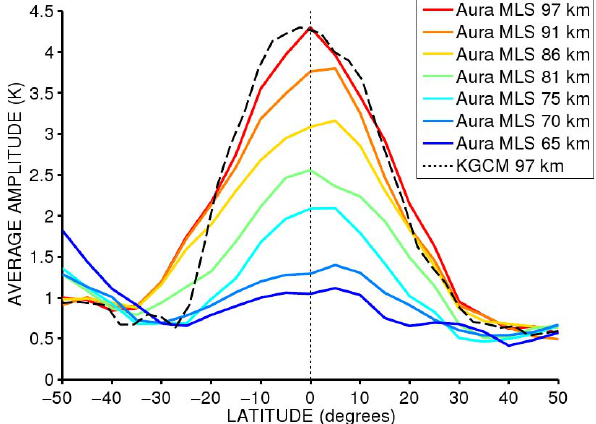
Fig. 9. Average amplitude as a function of latitude for 16 E1 waves identified in Aura MLS data for seven different heights between 65 and 97km. Only events with a maximum amplitude exceeding 3.5K were included. Also plotted is the amplitdue profile for 3.75 day waves at 97km height from the Kyushu-GCM (black dashed line), normalised to the largest amplitude in the MLS data.